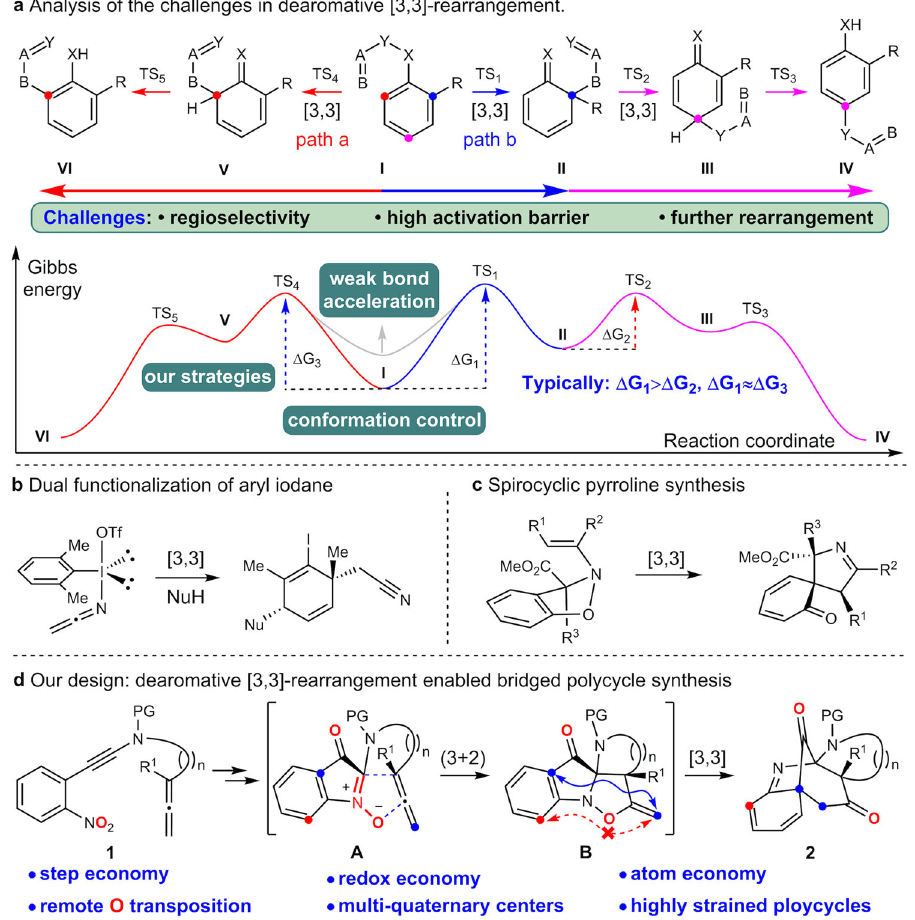
Fig.1|Dearomative[3,3]-rearrangementinef fi cientsynthesis.a Analysisofthechallengesindearomative[3,3]-rearrangement. b Dualfunctionalizationofaryliodane. c Spirocyclic pyrroline synthesis. d Our design: dearomative [3,3]-rearrangement enabled bridged polycycle synthesis. PG=protective